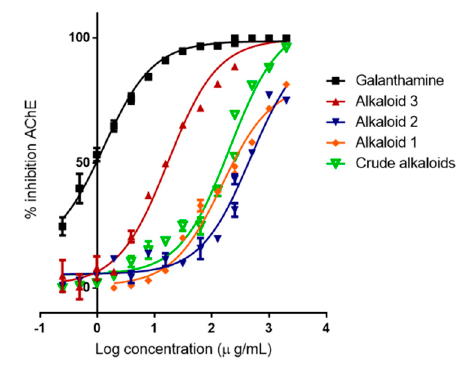
Figure 5. AChE inhibitory activity curves of isolated lycorin derivatives, crude alkaloids and the reference compound galanthamine.